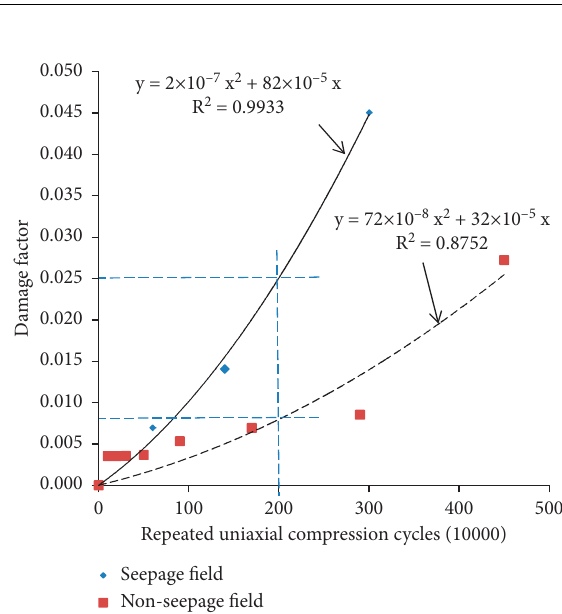
Figure 12: Relationship between the number of uniaxial loading cycles and the damage